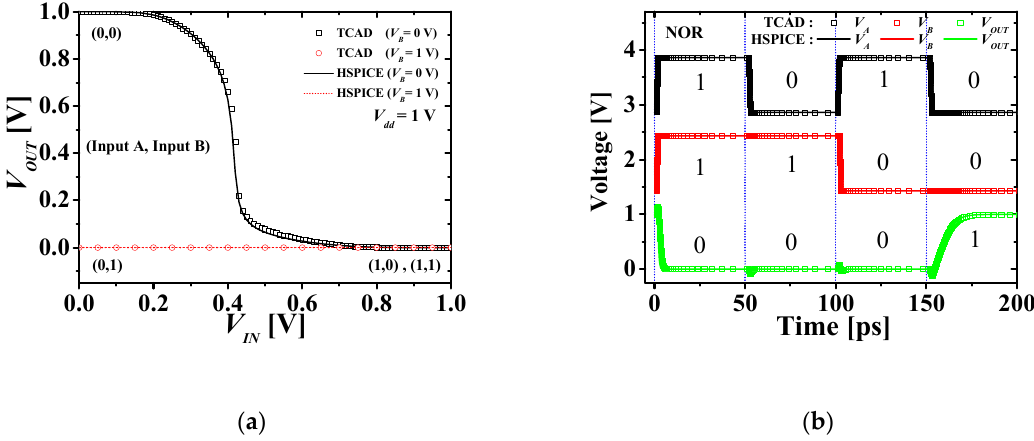
Figure 7. Comparison of ( a ) VTCs and ( b ) transient responses with TCAD and HSPICE in M3DNOR.